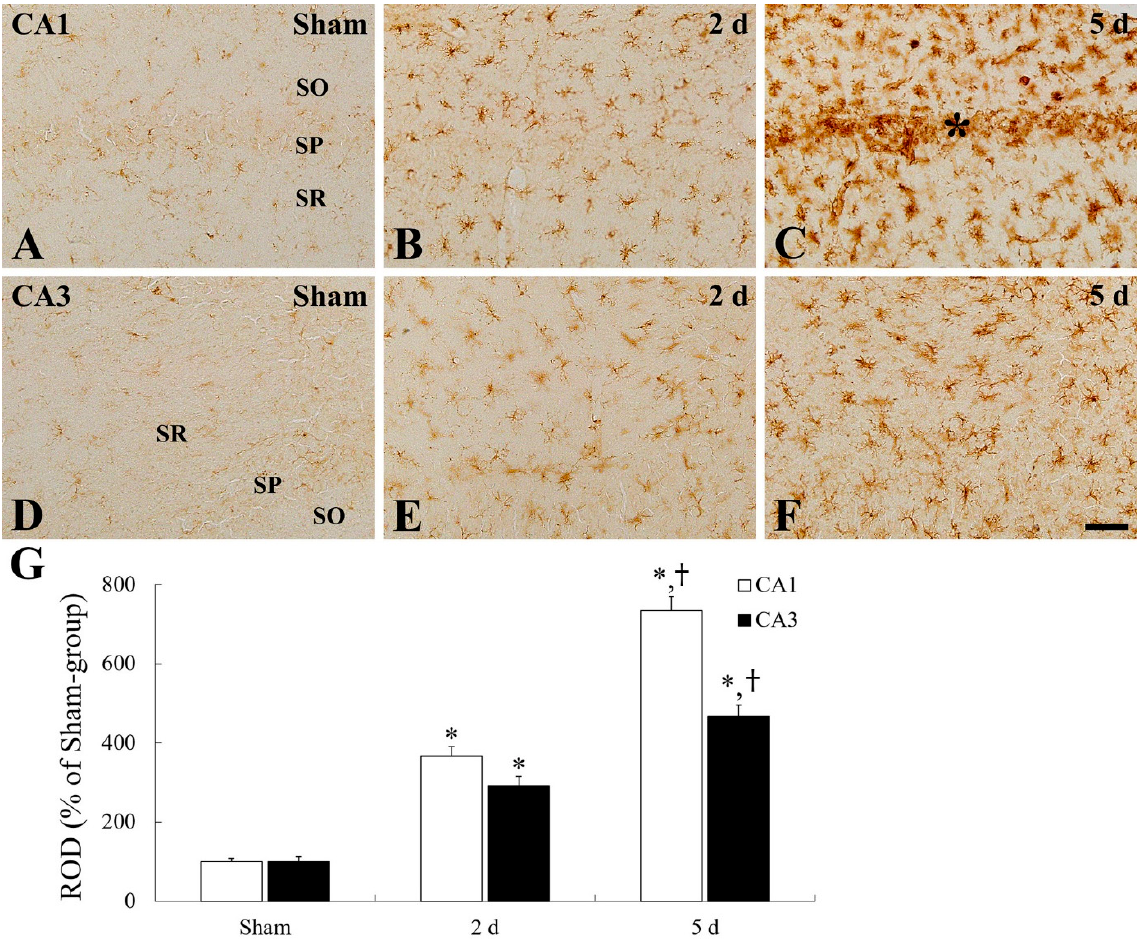
Figure 3. Immunohistochemical staining for Iba-1 in the CA1 ( A – C ) and CA2/3 ( D – F ) field of the sham group ( A , D ) and ischemia group ( B , C , E , F ) at 2 days ( B , E ) and 5 days ( A , C , D , F ) after tFI. The activation of Iba-1-immunoreactive microglia increases gradually with time after tFI, showing that tFI-induced Iba-1 immunoreactivity is much higher in the CA1 field than that in the CA3 field. Note that activated microglia are aggregated in the stratum pyramidale (SP, asterisk) at 5 days post-tFI only in the CA1 field. Scale bar = 50 µm. ( G ) Relative optical density (ROD) as percent of Iba-1-immunoreactive structures in the CA1 and CA2/3 field ( n = 7 at each time, * p < 0.05, significantly different from sham group, † p < 0.05, significantly different from pre-time point group). Bars in “G” indicate the means ± SEM.